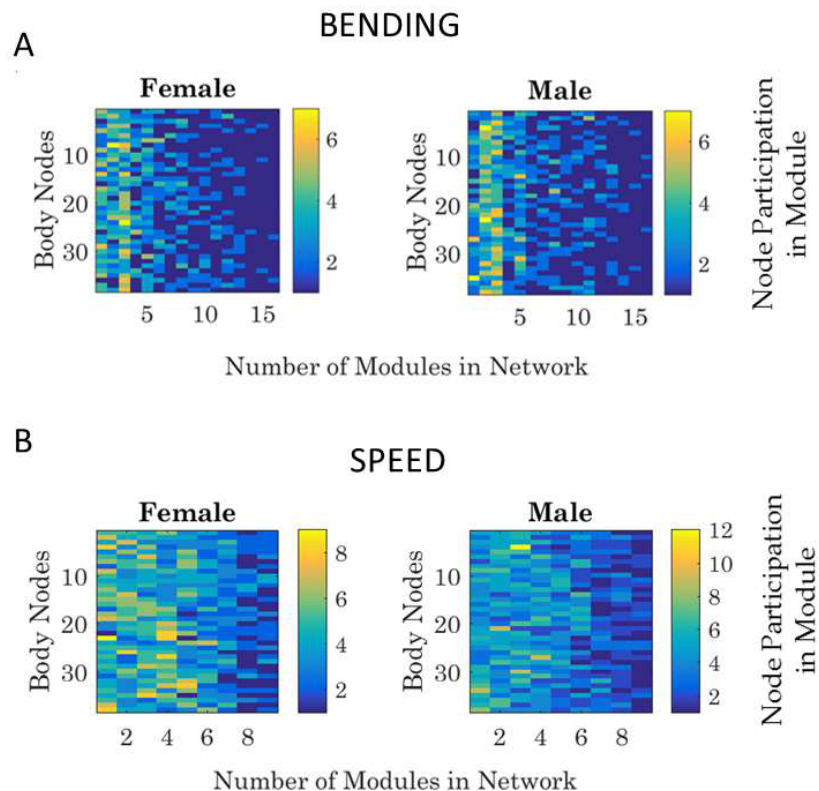
Figure 8. Sample use of the modularity metric across different 10-based frequency bands. ( A ) Different modules (16) self-emerge for each data block of the dynamically evolving network, as the routine unfolds for the female and male. ( B ) Counting the participation of each body node in each of the modules. The entry of the matrix (color map) gives the number of times (per units of time, e.g., minute) a node participates in a module (horizontal range from 1 to 16 from ( A )) for the female and male dancer, e.g., during the dancing condition in this case.